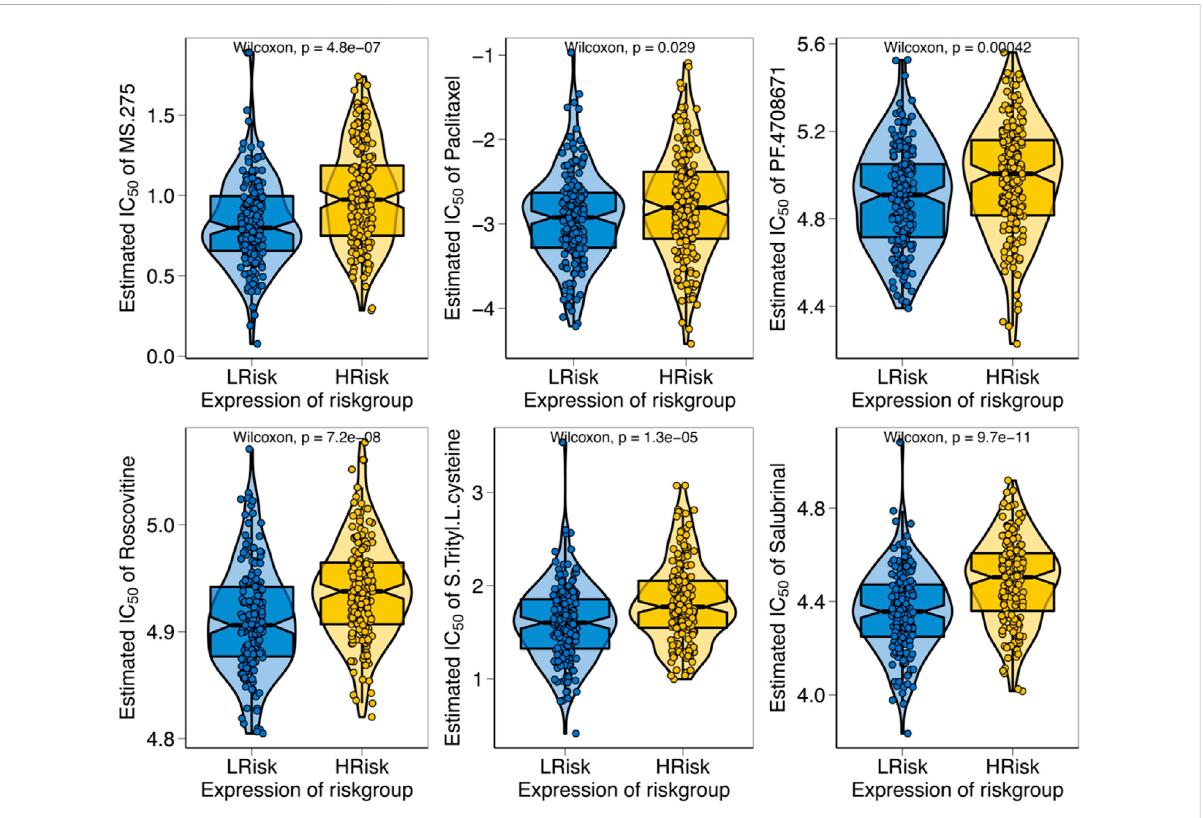
FIGURE 9 Relationship between apoptosis risk score and chemotherapy resistance. The fi gure illustratesthe correlation betweenthe apoptosis risk score and the IC 50 of various drugs in patients with